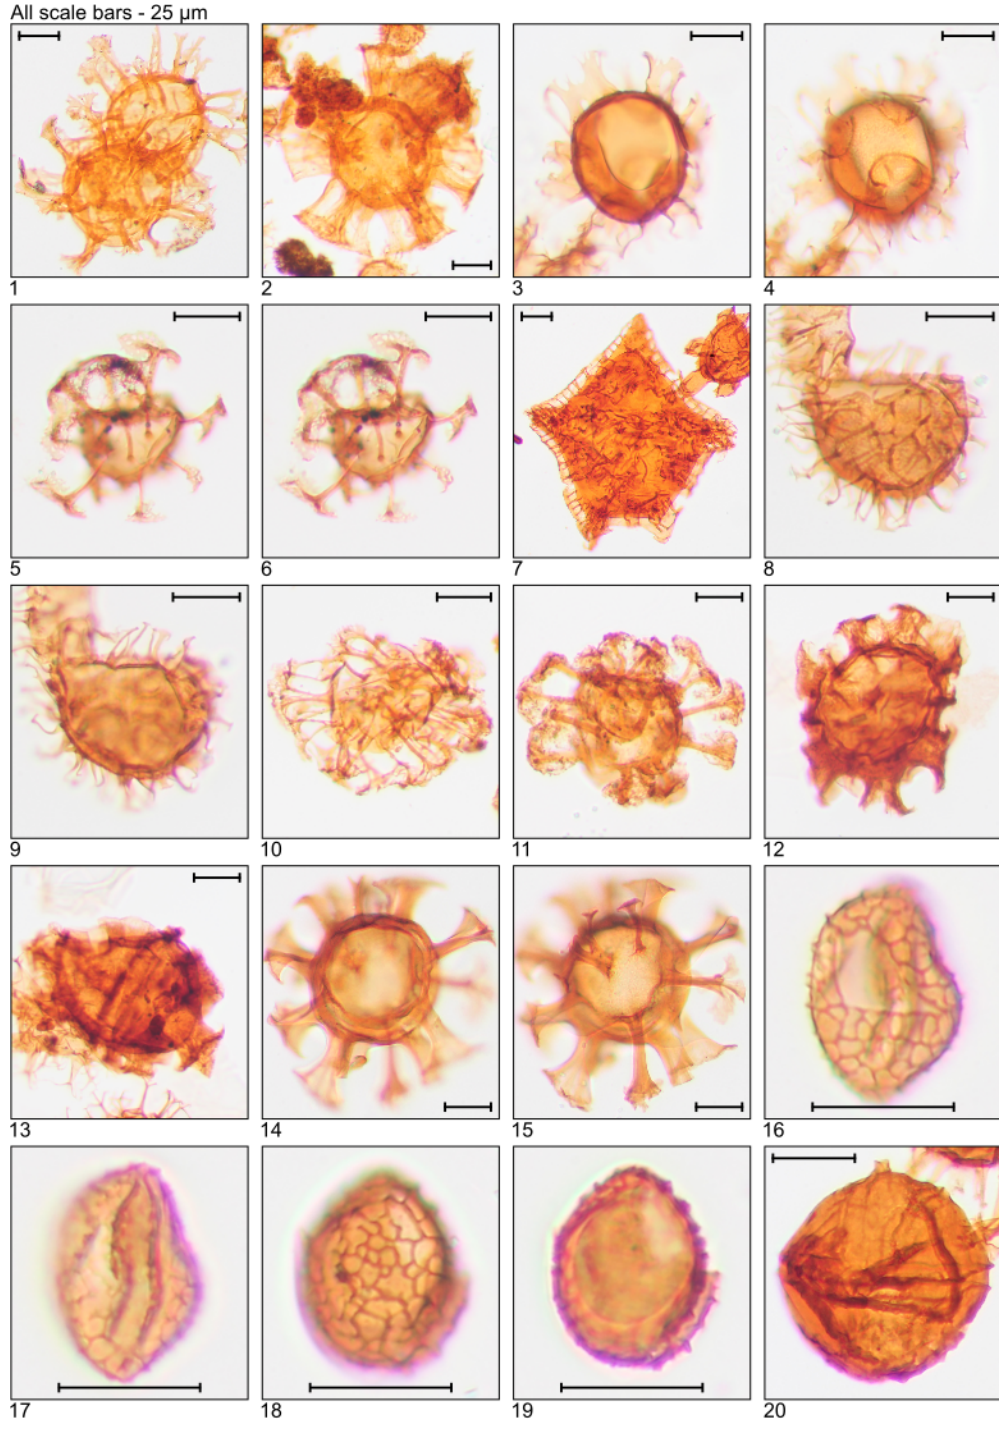
Plate 1. Illustration of taxa and sample or slide number. (1) Achomosphaera alcicornu (MG55; 16.8m; U15). (2) Araneosphaera